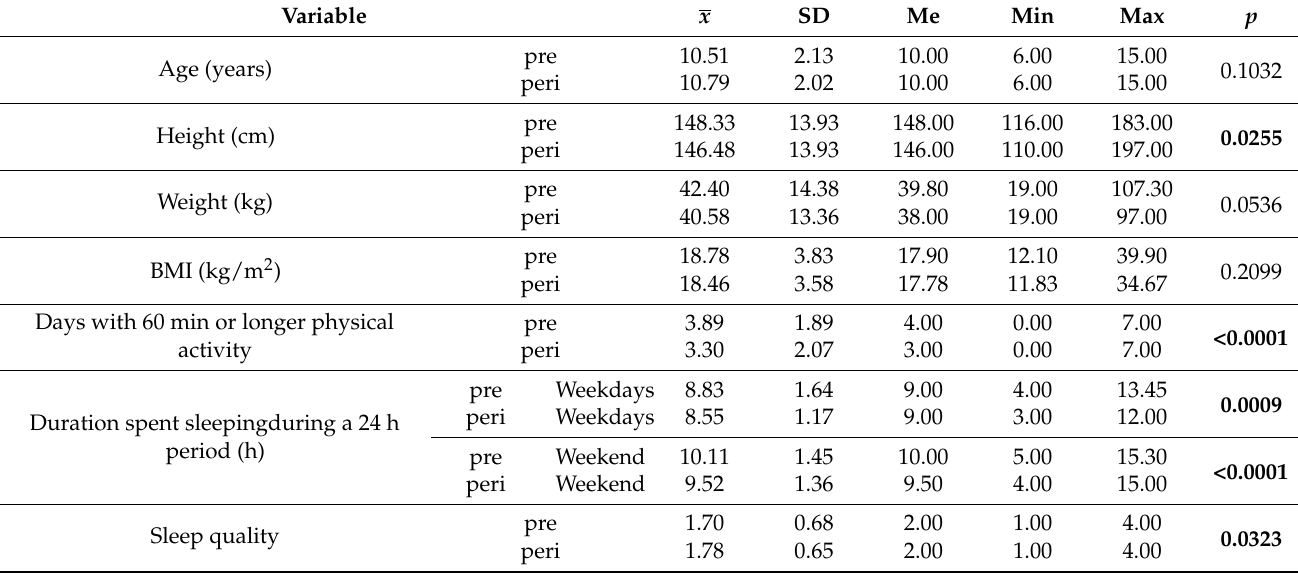
Table 1 . The pre‐ and peri groups differences. Table 1. The pre- and peri groups differences.